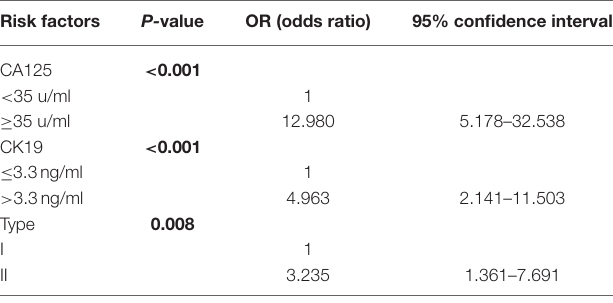
TABLE 2 | Logistic multivariate analysis of ovarian metastasis and relevant risk factors in total number of patients.